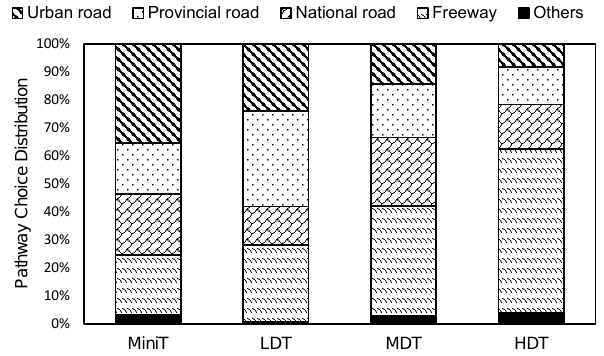
Figure 4. Proportion of running times on different types of